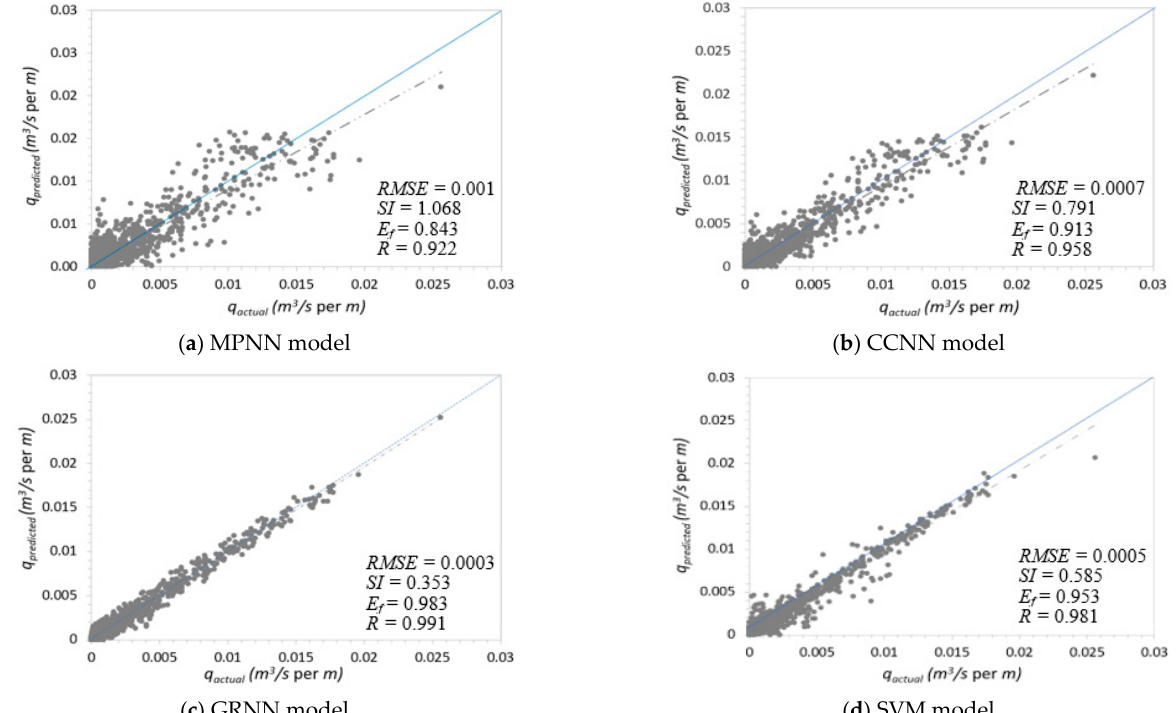
Figure 7. Scatter plots of the measured and predicted wave-overtopping values for various mod-